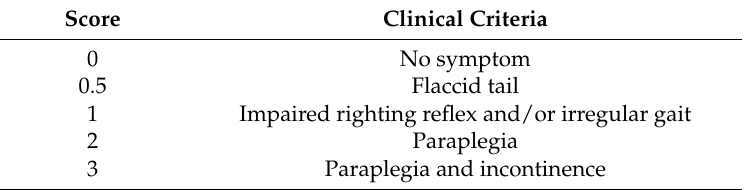
Table 1. Disease score determination for OSE and induced EAE models.